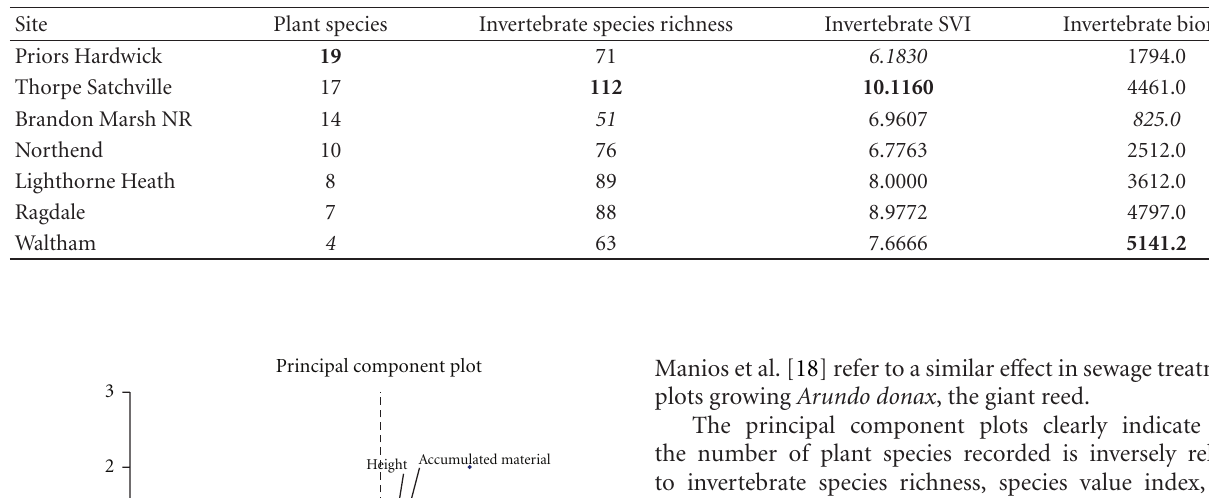
Table 3: Summary of “Fungib” invertebrate outputs and plant species recorded at each site. Invertebrate data for each reed-bed site has produced outputs from the computer programme “Fungib.” Highest scores are shown in bold and lowest in italic. It is immediately obvious that in reed-beds, plant species richness does not correlate with invertebrate species richness.